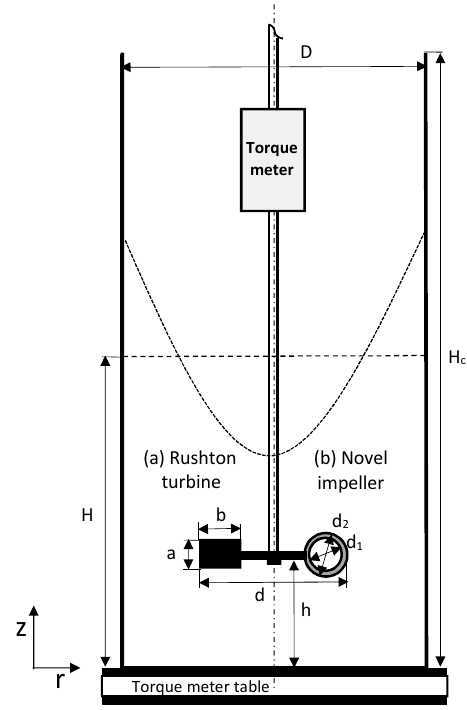
Fig. 1. Schematic diagram of the turbine and stirred tank.